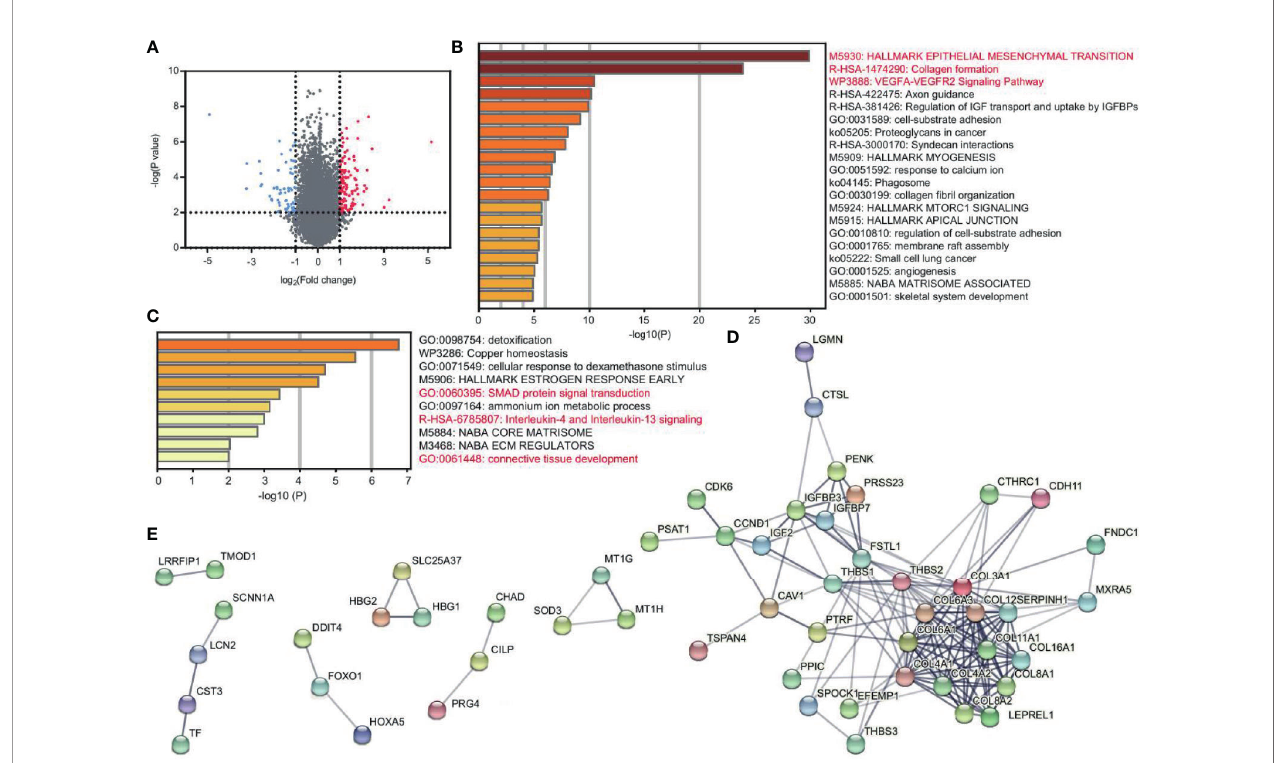
FIGURE 1 | DEGs reveal the characteristics of EC and CS. (A) Volcano plot of DEGs between patients (EC and CS) and normal controls. Red and blue dots represent the highly and lowly expressed genes in patients, respectively. (B, C) Metascape enrichment analysis for viewing the enrichment terms of upregulated (B) and downregulated (C) genes in patients. The color shows the p value. (D, E) PPI network of the upregulated (D) and downregulated (E) protein-coding genes in